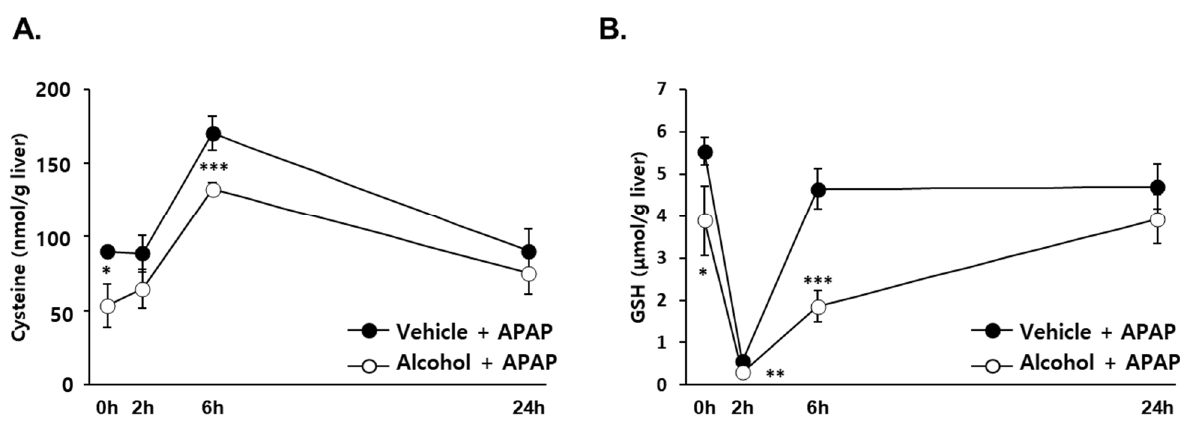
Figure 1. Alcohol pretreatment potentiates acetaminophen (APAP)-induced liver injury. Three consecutive doses of alcohol (5 g/kg, n = 20) or vehicle ( n = 20) were administered orally to mice at 12 h intervals. Twelve hours later, following the last alcohol dose (designated as APAP 0 h), APAP (300 mg/kg) was administered orally to mice. ( A ) Time-dependent activity of ALT in serum was measured at 0 h ( n = 5 in each group), 2 h ( n = 5 in each group), 6 h ( n = 5 in each group), and 24 h ( n = 5 in each group). ( B ) Histopathology of hematoxyline and eosin (H&E)-stained liver tissues at 24 h after APAP treatment. The results are expressed as the mean ± SD. **, *** Significantly different from the vehicle + APAP group (Student’s t test, p < 0.05, p < 0.01 and p < 0.001, respectively). Scale bar, 200 µ m; black dotted line, damaged area; CV, central vein; PV, portal vein.